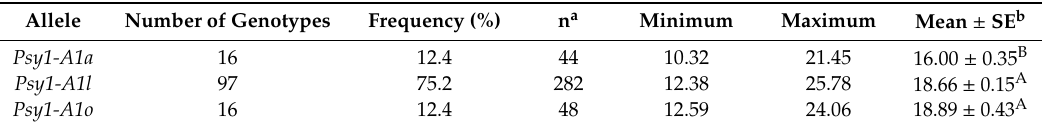
Table 4. Allele variants of the Psy1-A1 gene identified in the Mediterranean durum wheat panel and associated b* values.